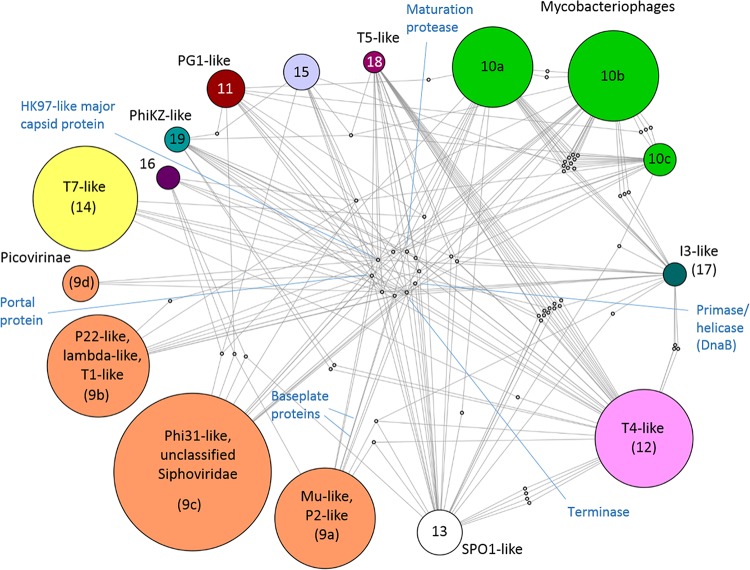
Internal structure of the Caudovirales supermodule. A module is linked to a connector gene if the prevalence of the gene in that module is greater than exp(−1). Modules are represented as larger circles, with sizes proportional to the number of genomes in the module; color coding is as shown in Fig. 4. Module 15 contains Siphoviridae from the Lactococcus phage 936 sensu lato and c2-like groups. Module 16 conatins Clostridium phage phiCP26F and related strains. Connector genes are represented as smaller gray nodes. Hallmark genes are labeled.